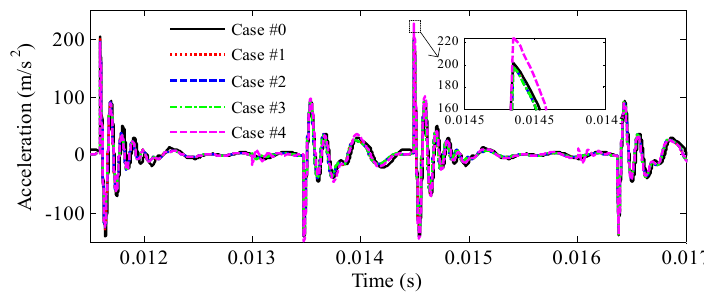
Figure 14. Effects of surface crack propagation on time domain of acceleration response.